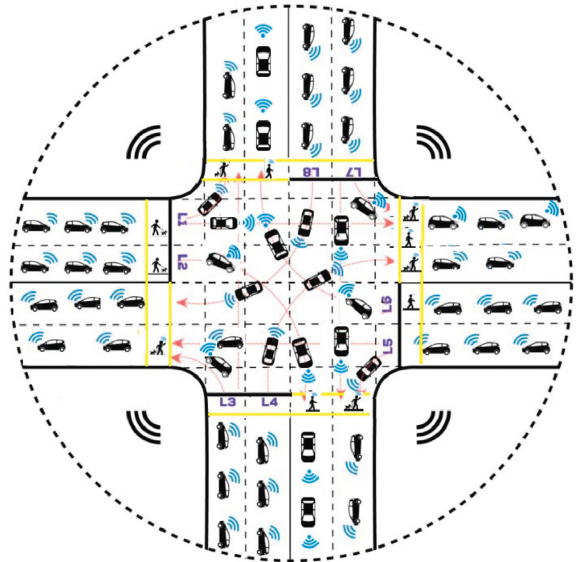
Figure 1: Intelligent transportation involving traffics, pedestrians, and